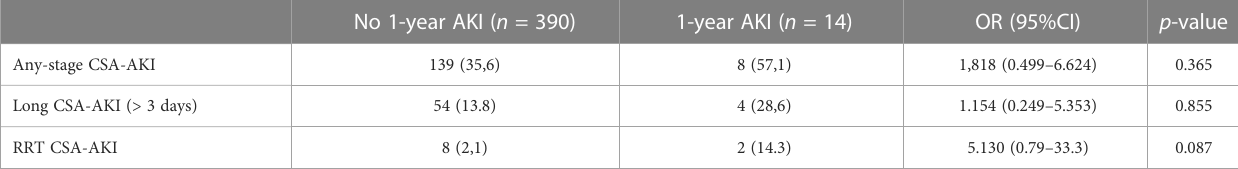
TABLE 6 Univariate analysis of CSA-AKI as a risk factor for new AKI during the 1-year follow-up visit. No 1-year AKI ( n = 390) Any-stage